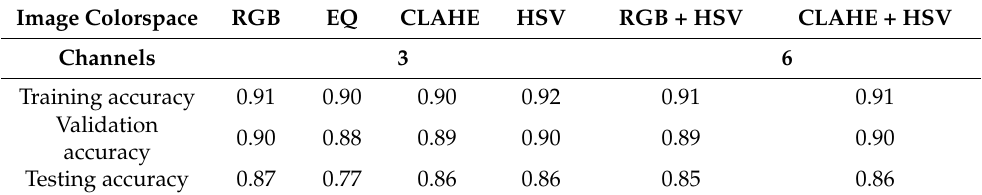
Table 3. Accuracy (dice coefficient) for investigated methods of segmentation.